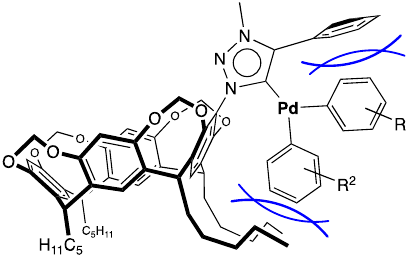
Figure 5. Catalysis with derivatives of 1 . Possible steric interactions during the catalytic cycle between the pentyl groups and the metal center.